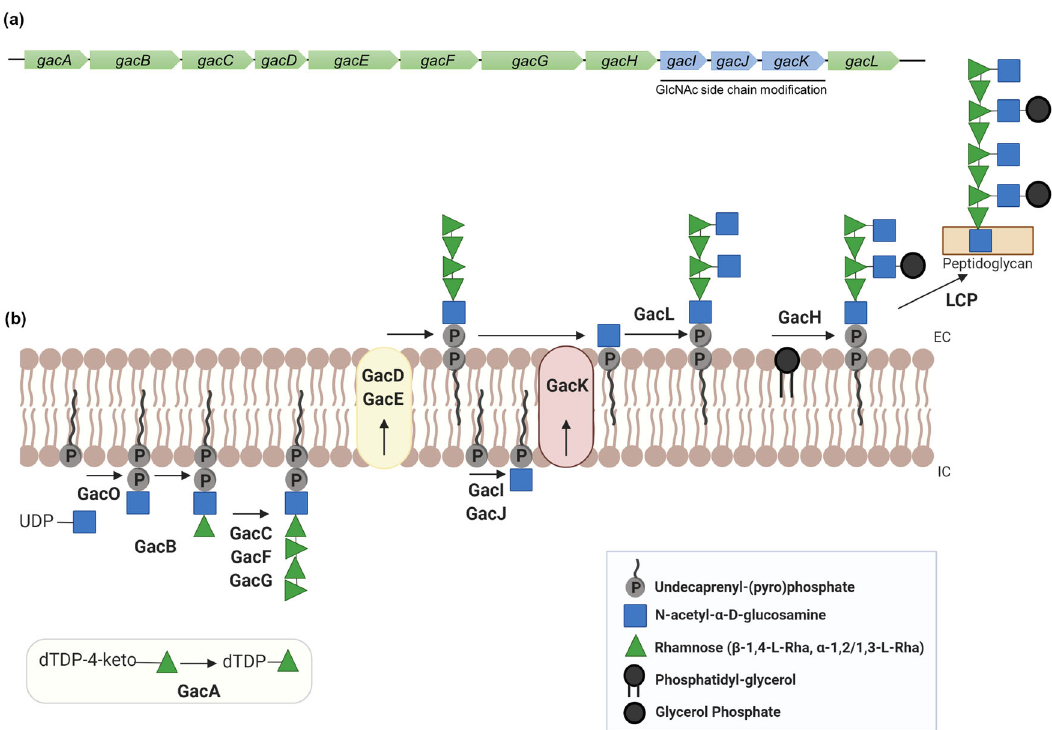
Fig. 4 The gac operon in Strep A produces GAC containing a polyrhamnose backbone decorated with alternate GlcNAc side chains. a Schematic representation of the gac operon ( gacA-L ) in Strep A. Horizontal arrows represent each gene designation with colour denoting predicted gene function. Green, polyrhamnose biosynthesis; blue, GlcNAc biosynthesis. b Schematic diagram of GAC biosynthesis. GAC biosynthesis is initiated on lipid linked GlcNAc attached to the inner lea fl et of the periplasmic membrane for polyrhamnose synthesis catalysed by rhamnosyltransferase enzymes (GacBCFG). After polymerisation, the polyrhamnose backbone is fl ipped to the outer lea fl et by an ABC transporter (GacDE complex) before GlcNAc (GacL) and glycerol phosphates (GacH) are transferred to the polyrhamnose backbone as a sidechain modi fi cation. A LytR-CpsS-Psr (LCP) phosphotransferase protein is hypothesised to attach GAC to peptidoglycan via a phophodiester bond 17